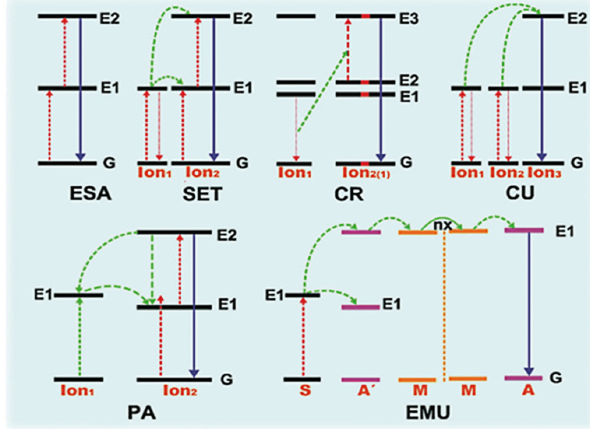
Figure 3. Principal diagram for the up-conversion processes of Ln 3+ –doped crystals, including excited-state absorption (ESA), successive energy transfer (SET), cross-relaxation (CR), cooperative up-conversion (CU), photon avalanche (PA), energy migration-mediated UC (EMU) mechanisms. The red, green, and purple lines stand for photon excitation, energy transfer, and emission processes, respectively. Reprinted with permission from Ref. [66]. Copyright 2021, John Wiley and Sons.